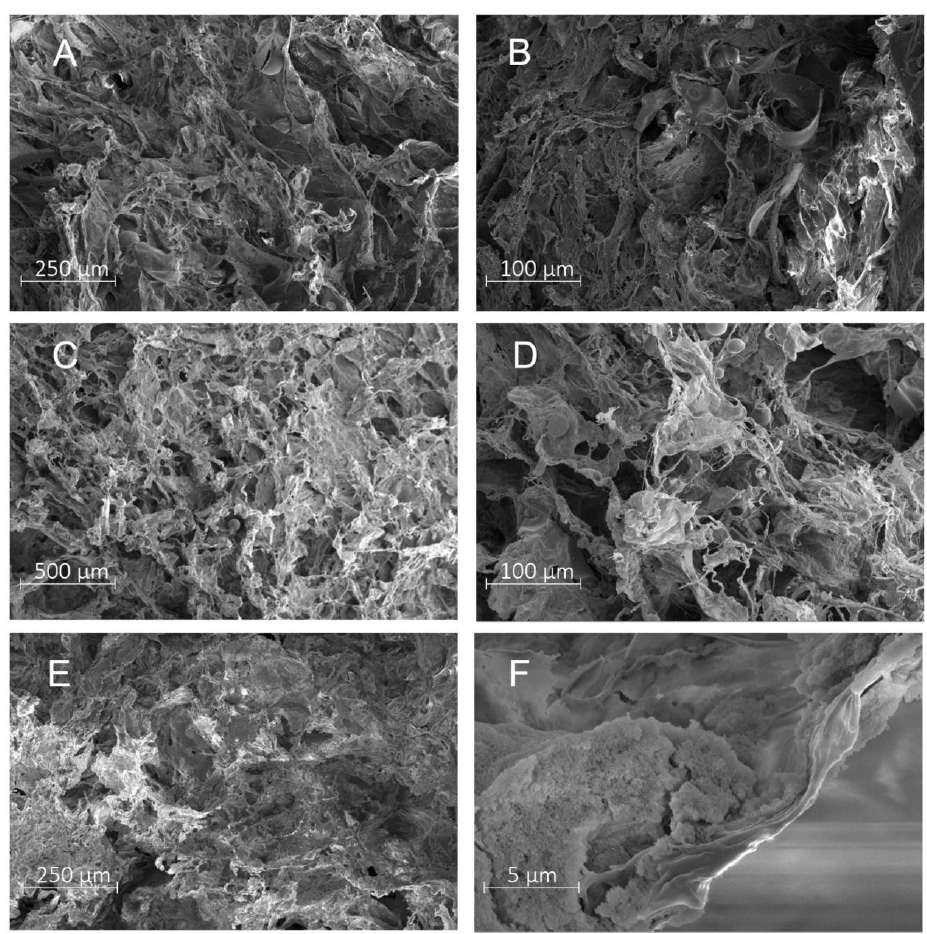
Figure 1. SEM images of the porous matrices; ( A , B ) PLA/PVA-AMI; ( C , D ) PLA/PVA-CH-AMI; and ( E , F ) PLA/PVA-SiO 2 -AMI.